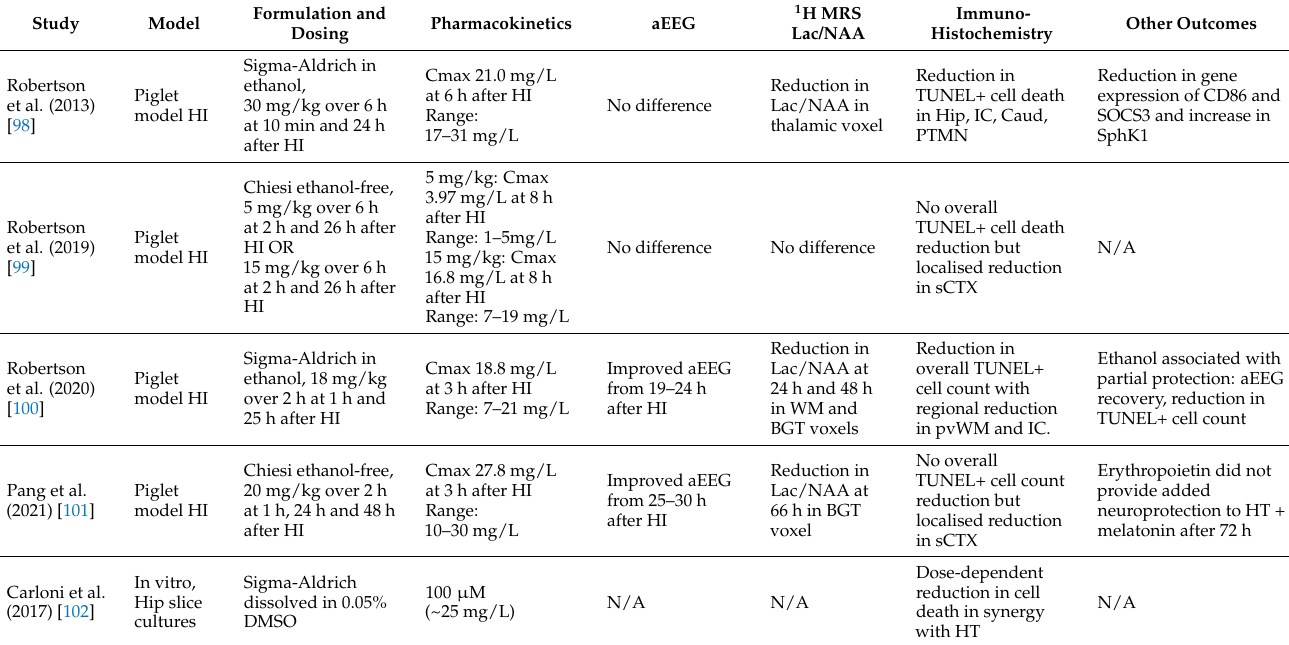
Table 1. Preclinical Studies Evaluating Melatonin Combined with Hypothermia for Neonatal